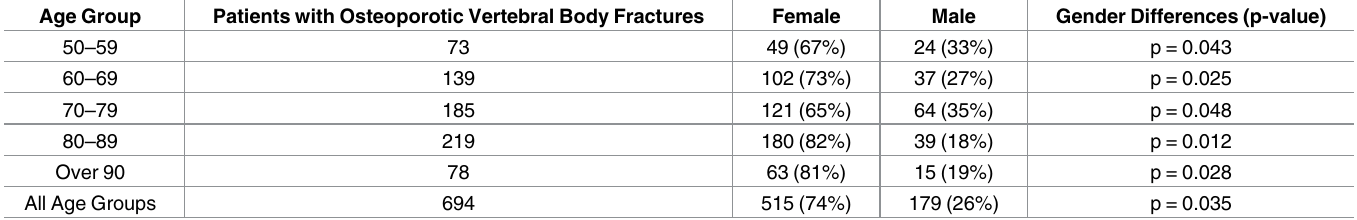
Table 1. Osteoporotic fractures. Distributionof patients with osteoporoticfractures. Age